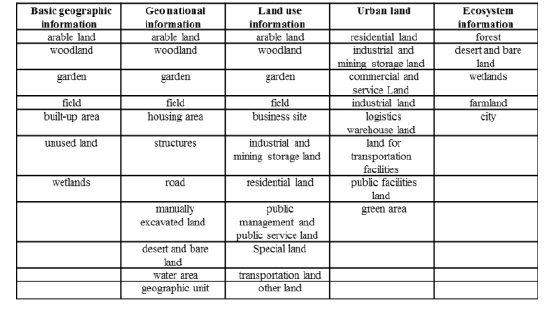
Table 1. Comparision of land use classification system between main functional areas land use, ecological environment and urban planning